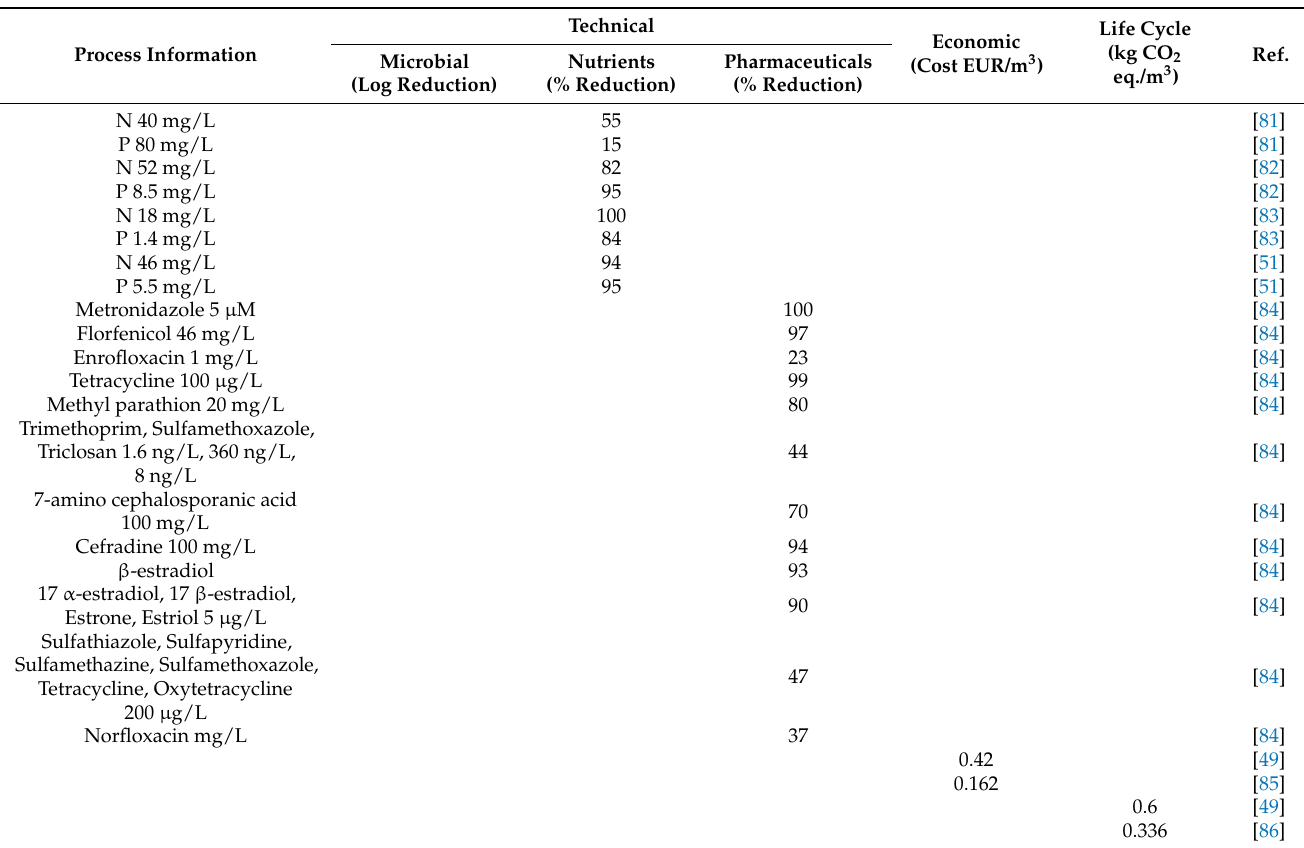
Table A5. Literature data used for scoring the microalgae.